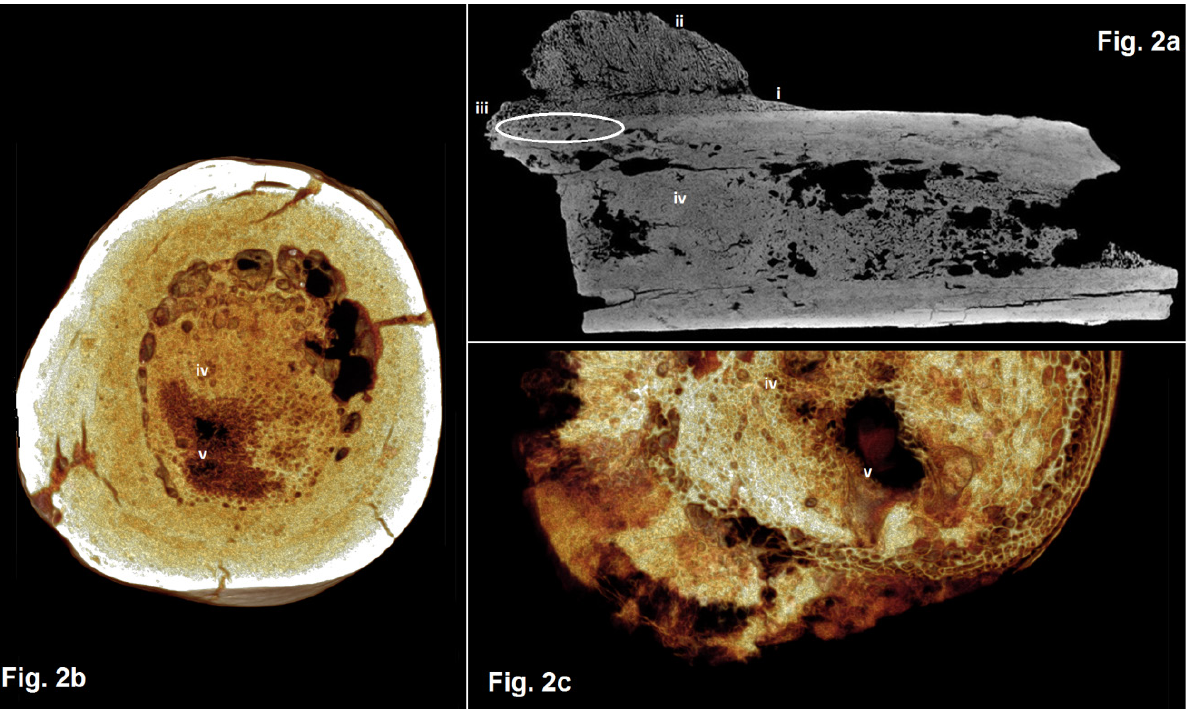
Figure 2: (a) Axial micro-CT orthoslice indicating (i) reactive new bone formation subperiosteally forming a Codman triangle, (ii) ossified exophytic (cauliflower-like) and/or spiculated mass adjacent to the bone, (iii) localised sub-periosteal invasion by the mass into the cortex, (iv) remodelled bone infill; (b) transverse rendered view of SK 7923; (c) transverse rendered view of modern clinical case of osteoblastic osteosarcoma with aggressive local medullary infilling (Courtesy: Department of Anatomy, University of Pretoria). Note (v) the homologous combination of spongy and solid bone between the fossil and clinical